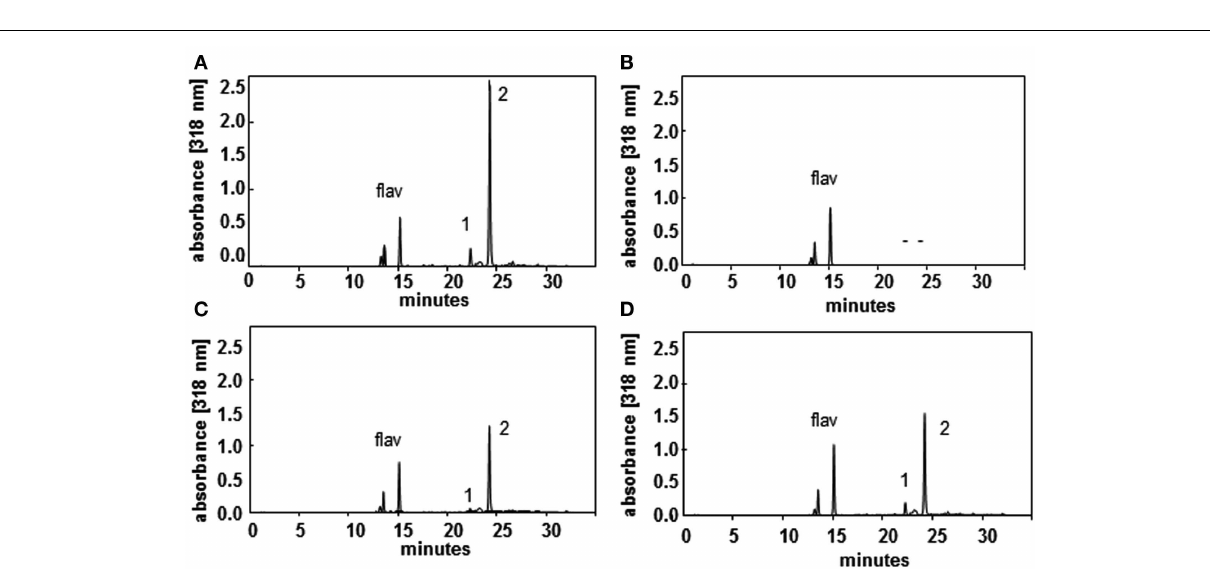
FIGURE 5 | HPLC profiles of wild type (A), sht (B), spds1 (C), and samdc1 (D) pollen recorded at 318nm illustrate the effects on HCAA-formation in the mutants. Major HCAAs ( N 1 , N 5 , N 10 -tris-5-hydroxyferuloyl spermidine, (1) and N 1 , N 10 -bis-(5-hydroxyferuloyl)- N 5 -sinapoyl-spermidine and (2) as well as flavonoids (flav) are